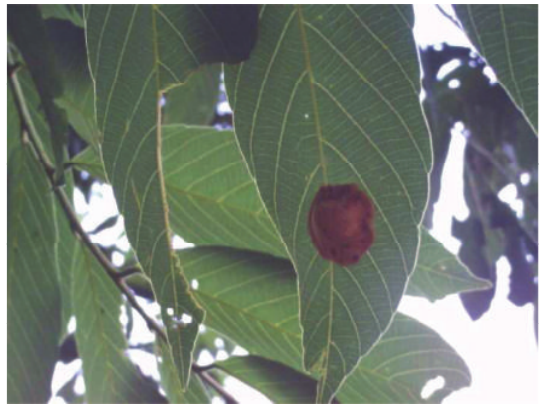
Figure 6: A. panda host plant Bridelia micrantha with egg cluster in the Kakamega